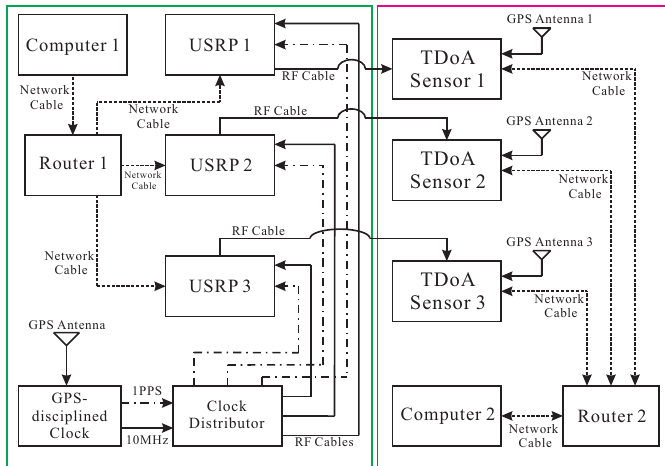
Figure 3. The block diagram of the hardware part of the proposed performance-evaluation approach for a TDoA localization system. The left (green box) and the right (magenta box) sides show the hardware part of the approach and an example of TDoA localization system under test,